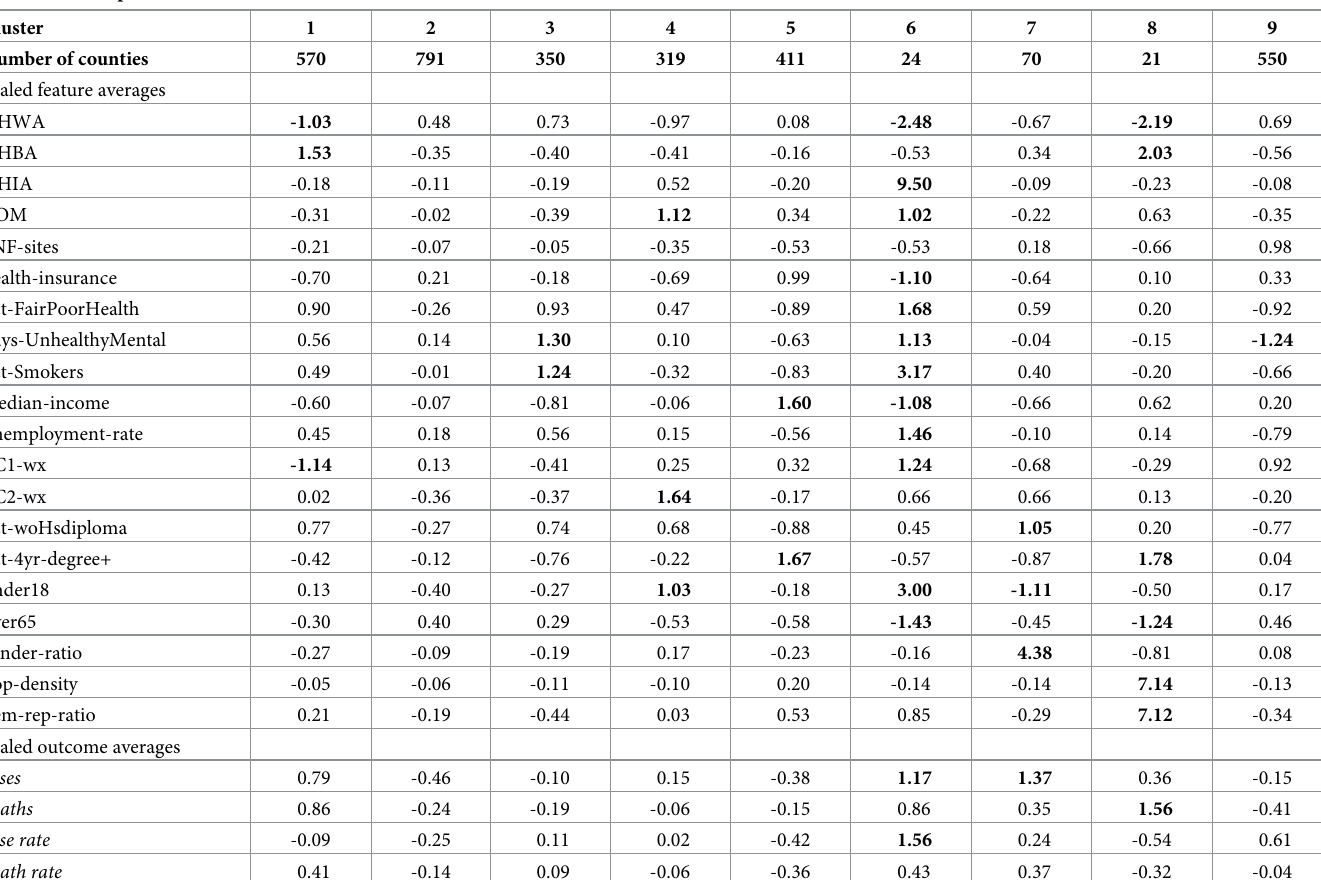
Table 6. Cluster